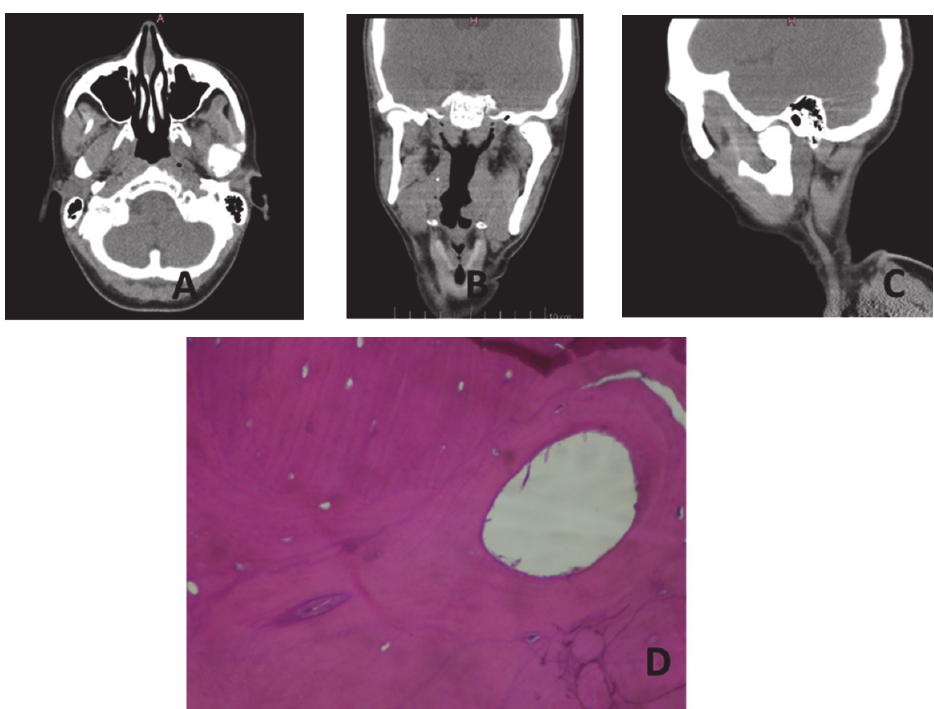
Figure 4. ( A ) Transverse section of CT imaging. There is an obvious enlargement of the left mandib- ular condyle; ( B ) Coronal view showing the affected left side in comparison with the healthy right side; ( C ) Oblique section of CT imaging. The enlarged left condyle is depicted; ( D ) Condylar osteoma consisting of osteocytes and haversian canals H & E X400.